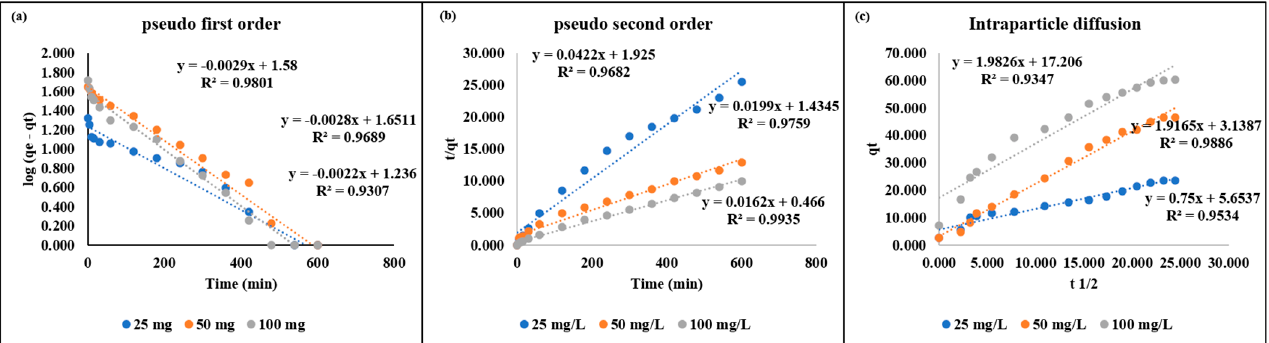
Figure 4. Kinetic modelling of the adsorption of Cr(VI) on Fe 3 O 4 NPs material, ( a ) pseudo ‐ first ‐ order kinetic plot, ( b ) pseudo ‐ second ‐ order kinetic plot, ( c ) intra ‐ particle diffusion plot.